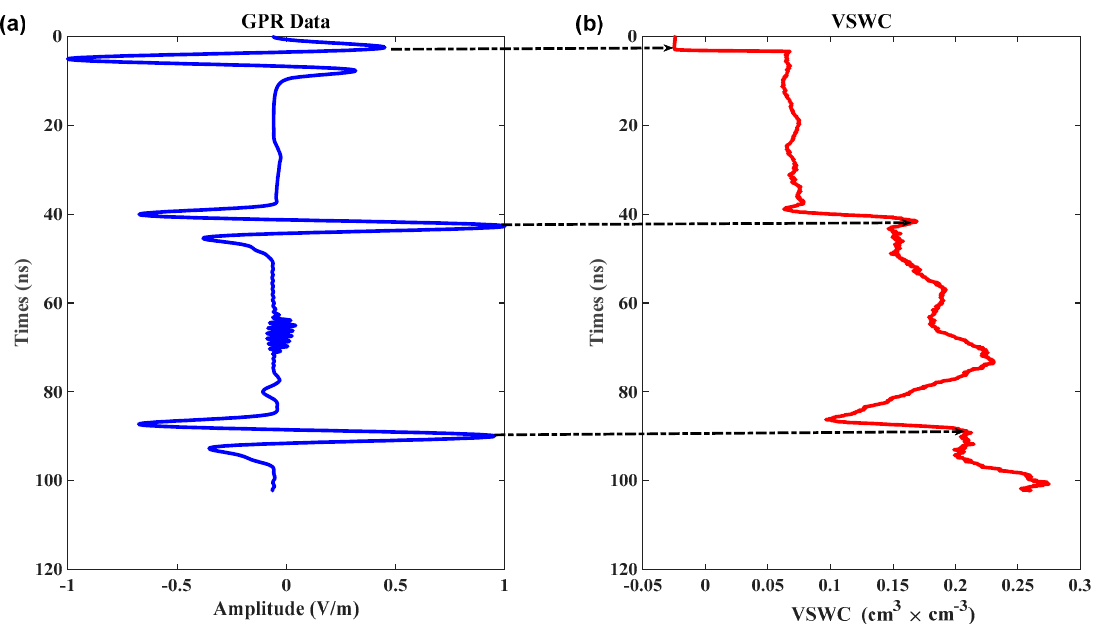
Figure 2. A-scan conversion to single-channel VSWC correspondence. ( a ) Single-channel GPR data and ( b ) Single-channel VSWC data.